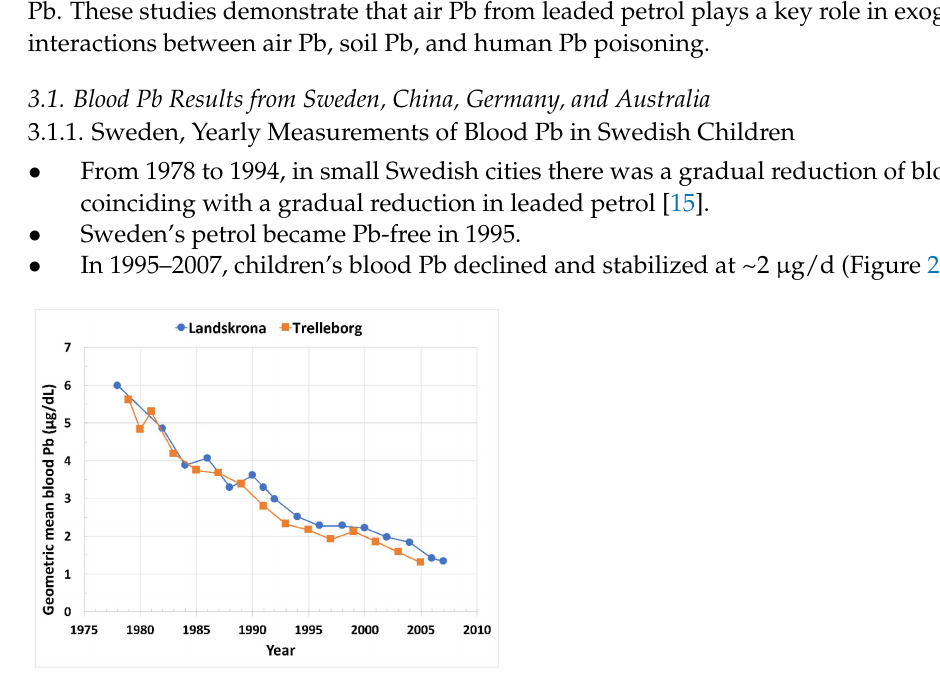
Figure 2. Blood Pb decreases in two small Swedish cities, Landskrona and Trelleborg. This graph was modified from the published data using WebPlotDigitizer Version 4.5 (Pacifica, CA, USA)